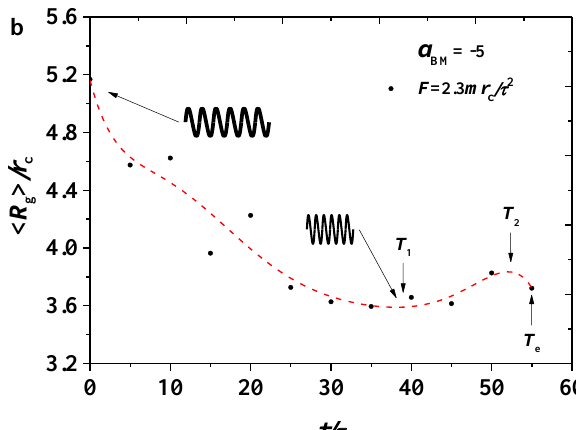
Figure 2. Variation of gyration radius for the bottlebrush polymers of a BM = − 5, where the red dotted lines are the fitting results with ( a ) the pulling force of F = 1.7 mr c / τ 2 and ( b ) the pulling force of F = 2.3 mr c / τ 2 , respectively.